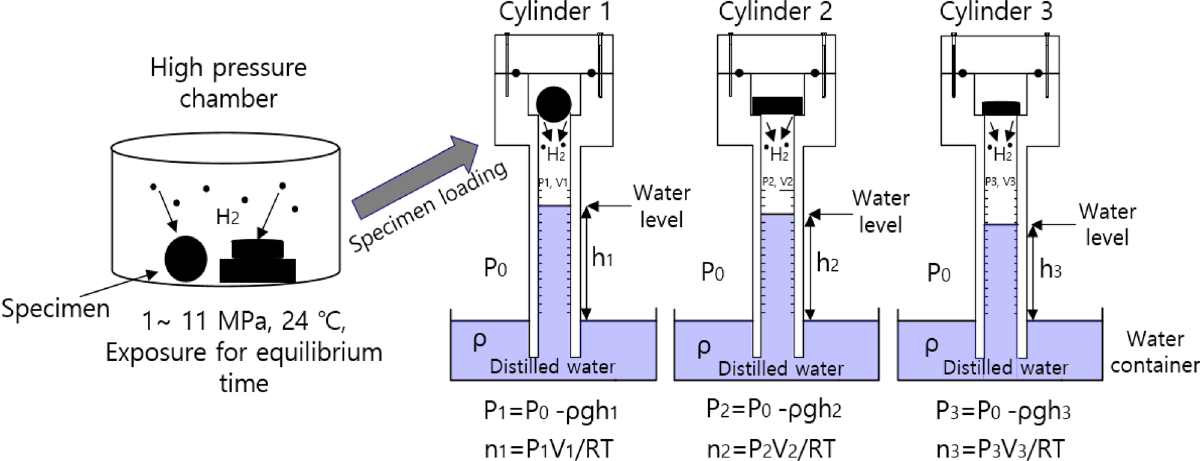
Figure 1. Schematic diagram of the three-channel volumetric measurement system in which three cylinders are standing. The blue part indicates the distilled water filled in water containers and